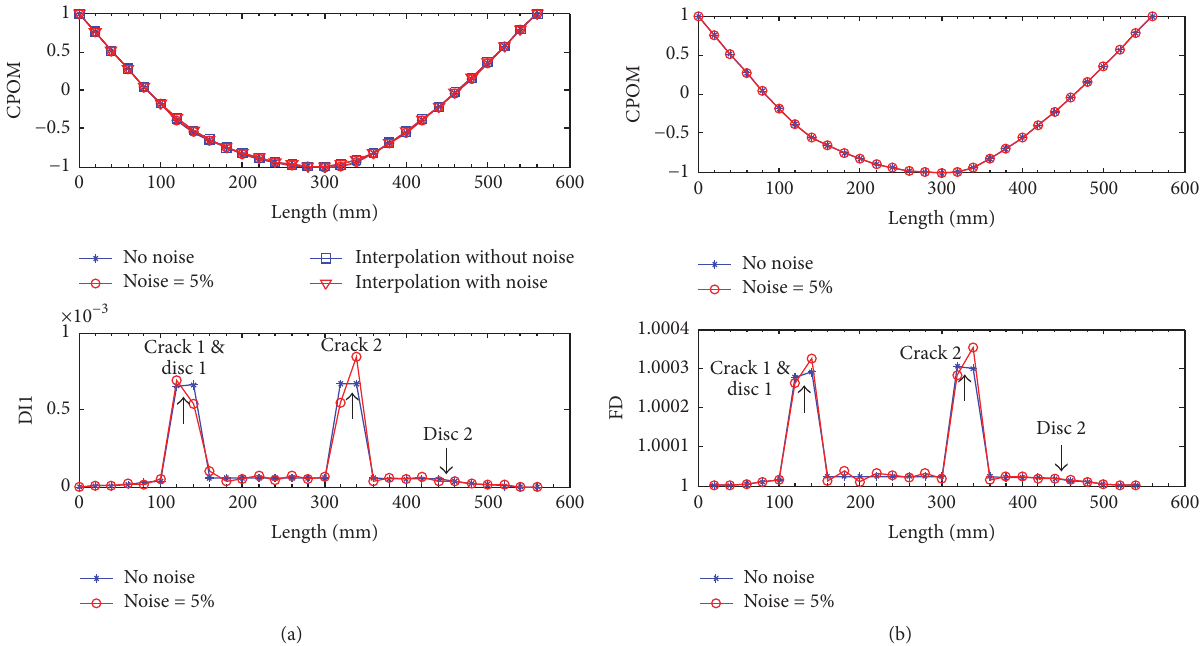
Figure 12: Localization results of double-cracked rotor in case 5. (a) Localization using GSM by linear gapped interpolation. (b) Localization using